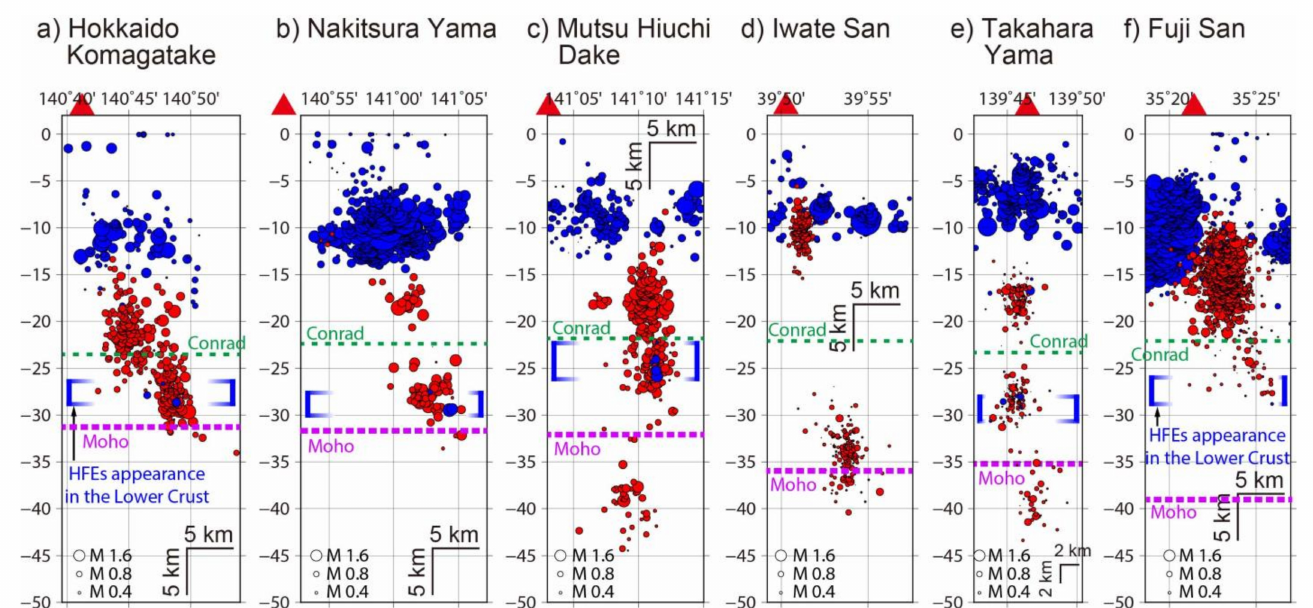
Figure 2. Hypocenter distribution of deep low-frequency earthquakes (LFEs, red circle) and ordinary high-frequency earthquakes (HFEs, blue circle) on the four E–W cross sections (Hokkaido Komagatake, Nakitsura Yama, Mutsu Hiuchi Dake, and Takahara Yama) and on the two N–S cross sections (Iwate San and Fuji San) in the same areas of insets as in Figure 1. A few HFEs are observed in the depth of 31–22 km of the lower crust in the five volcanic